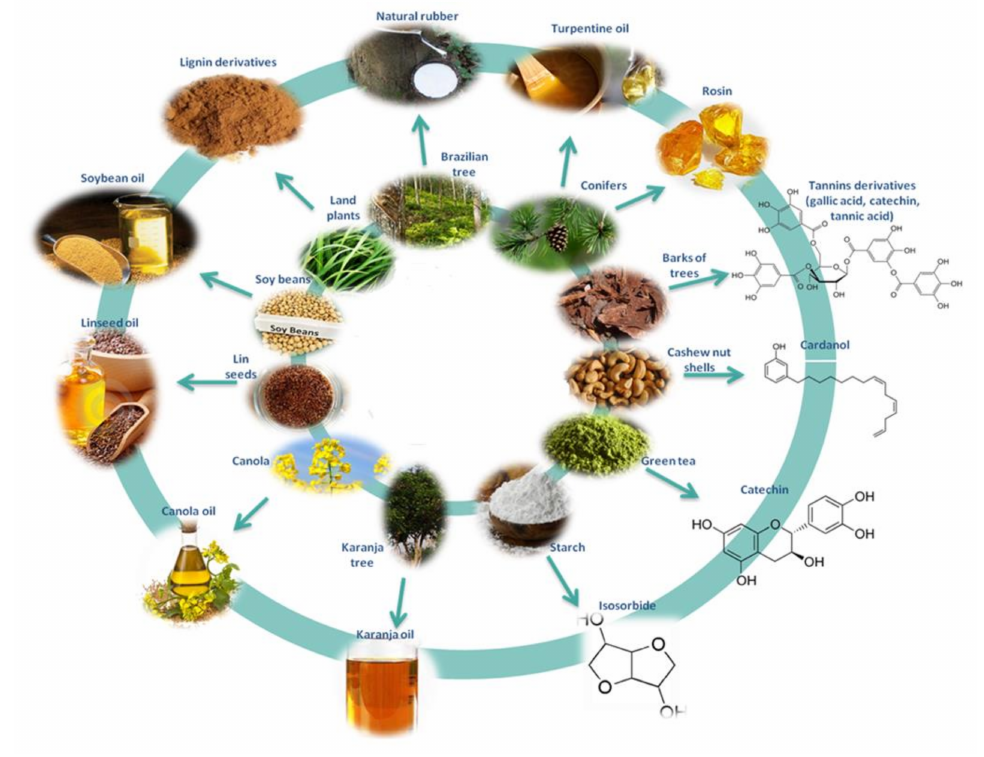
Figure 2. A selection of renewable resources for resin systems. Reprinted from ref.